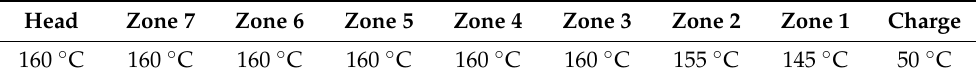
Table 2. The set temperature of the heating zones for the twin-screw extruder.